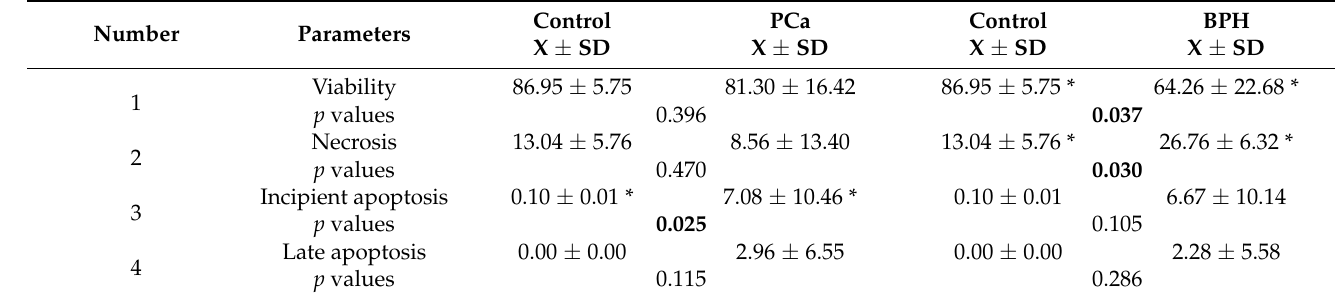
Table 4. Cell apoptosis at prostate adenocarcinoma and benign prostatic hyperplasia cases reported to control